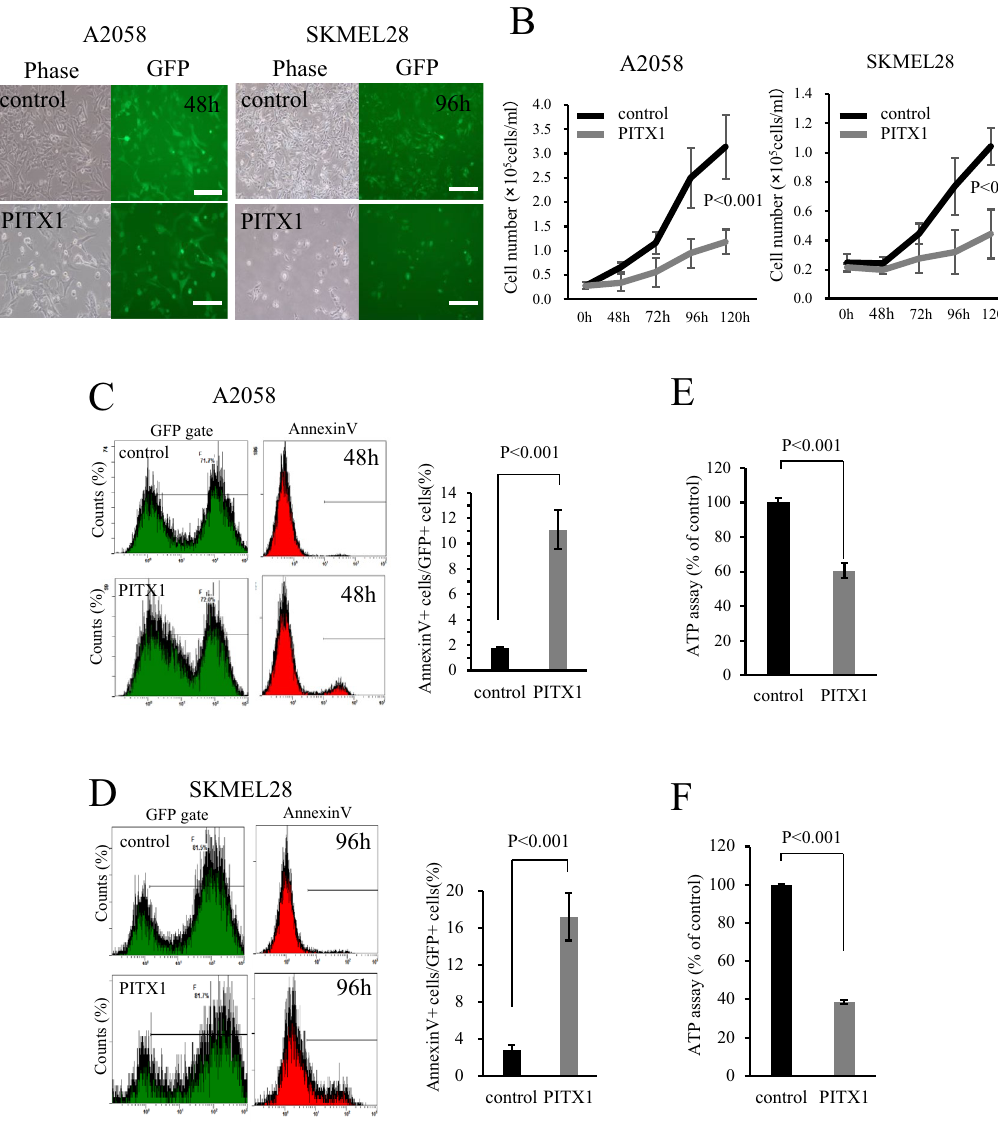
Figure 1. Overexpression of PITX1 inhibits melanoma proliferation. ( A ) A2058 and SKMEL28 cell lines were infected with control and PITX1 expression lentivirus vectors. Infection efficiency was monitored after 48 h or 96 h by fluorescence analysis of vector-encoded GFP (right panels). Phase contrast images are shown at left. Scale bars: 100 µm. ( B ) Number of PITX1 transfected cells and control cells over 5 days. A2058 cells are shown at left, and SKMEL28 cells are shown at right. Bars correspond to means ± S.D. for three independent experiments (P < 0.001). Curve images of growth were created using Excel. ( C , D ) Flow cytometric analysis of apoptosis in PITX1 overexpressing cells ( C : A2058, D : SKMEL28). Quantification of apoptosis as % Annexin V positive cells in GFP positive gate. Bars correspond to means ± S.D. of three independent experiments (P < 0.001). Annexin V-positive cell count images were created using Kaluza software, and the bar graphs were created using Excel. ( E , F ) ATP assay in PITX1 -overexpressing cells ( E : A2058, F : SKMEL28). ATP content was measured using CellTiter-Glo 2.0 After Assay Kit at 96 h after infection with PITX1 expressing or control lentivirus vector. Values are expressed as a percentage of control. Bars correspond to the means ± SD of three independent experiments ( P < 0.001). These bar graphs were created using